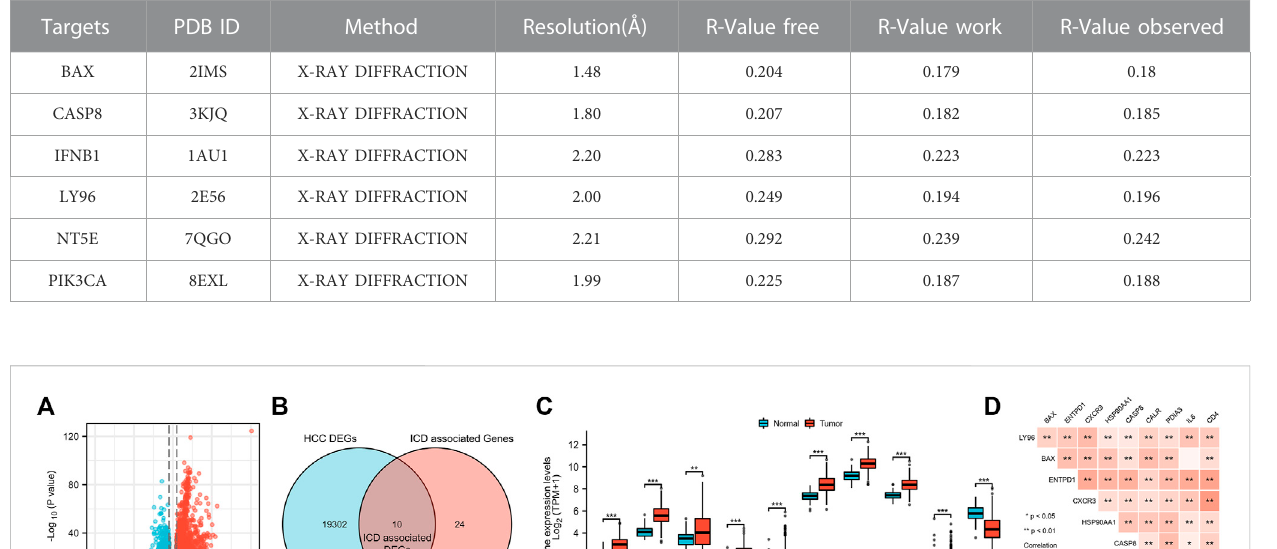
TABLE 1 Protein information of six ICD-related genes (ICD: immunogenic cell death).